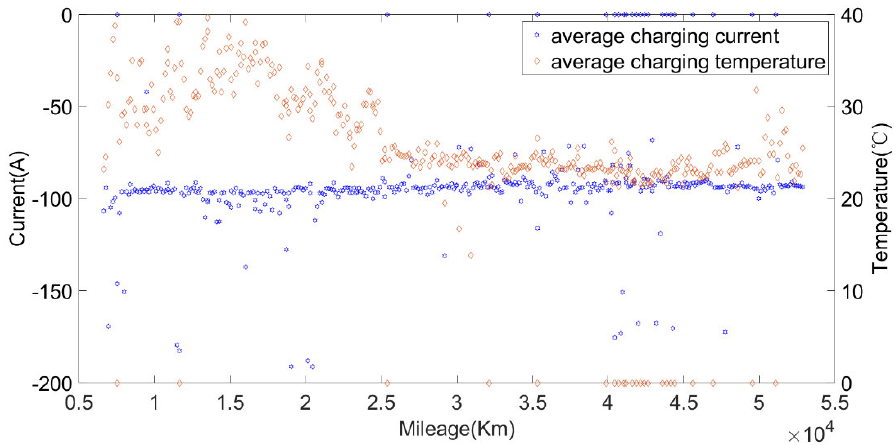
Figure 19. The relationship between the charging current, average charging temperature and